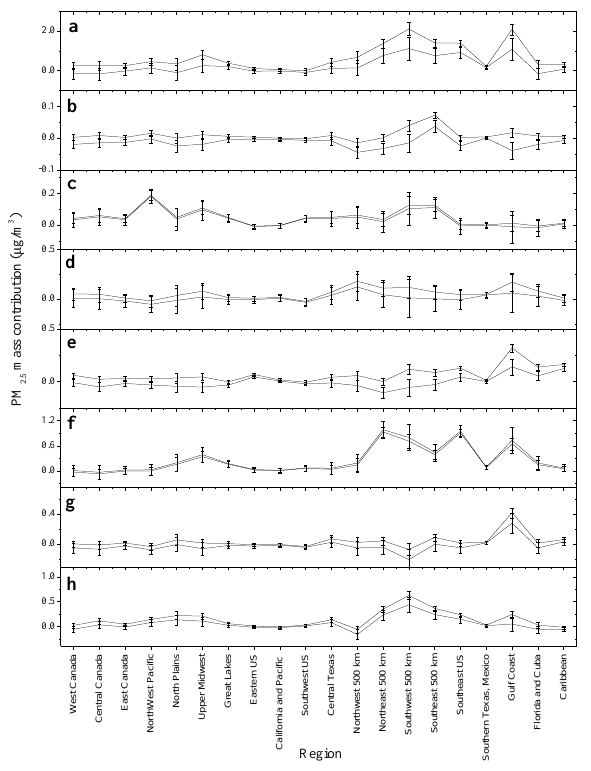
Figure 7. Contributions of predefined source regions on PM 2.5 mass (a), primary traffic 2 Fig. 7. Contributions of predefined source regions on PM 2 . 5 mass particles (b), secondary nitrate (c), diesel particles (d), aged sea salt particles (e), secondary 3 (a) , primary traffic particles (b) , secondary nitrate (c) , diesel parti- sulphate (f), mineral dust particles (g) and biomass burning particles (h) in Little Rock, 4 cles (d) , aged sea salt particles (e) , secondary sulphate (f) , mineral Arkansas. 5 dust particles (g) and biomass burning particles (h) in Little Rock, Arkansas.